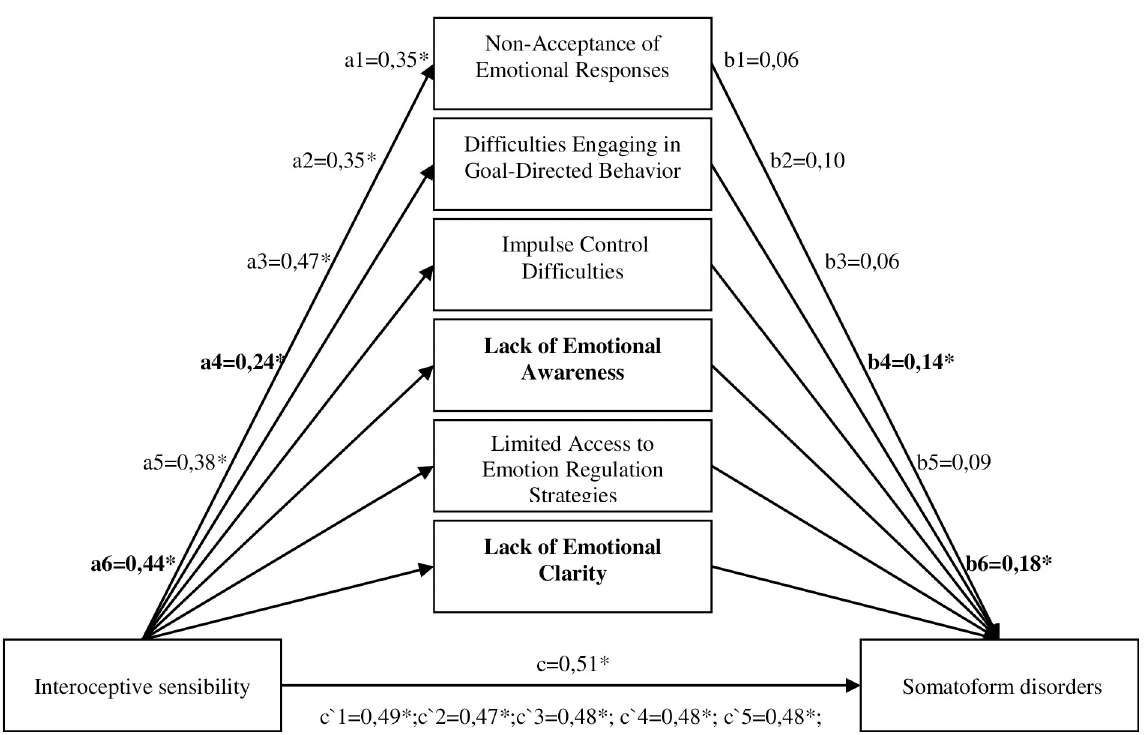
Fig 5. The model of mediation for the tendency toward difficulty in regulation emotion between the impact of interoceptive sensibility (autonomic reactivity) on the level of somatoform disorders. � -p < 0,05; Significant mediation relation are marked in bold. Direct effect–X on Y without the influence of M1 –c. Indirect effect of X on Y through M—a1,b1; a2,b2; a3,b3; a4,b4; a5,b5; a6,b6. Direct effect–X on Y including the influence of M–c‘1; c‘2;c‘3,c‘4,c‘5,c‘6. Interoceptive sensibility (autonomic reactivity) was measured by Body Perception Questionnaire- Short Form (BPQ-SF). Somatoform disorders was measured by Somatoform Dissociation Questionnaire (SDQ-20). Difficulty in regulation emotion was measured by Difficulties in Emotion Regulation Scale